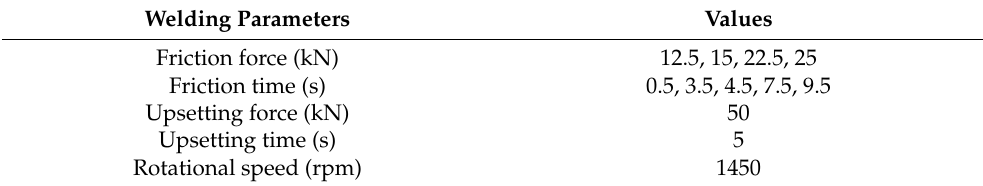
Table 2. Welding parameters used in the friction welding experiments.